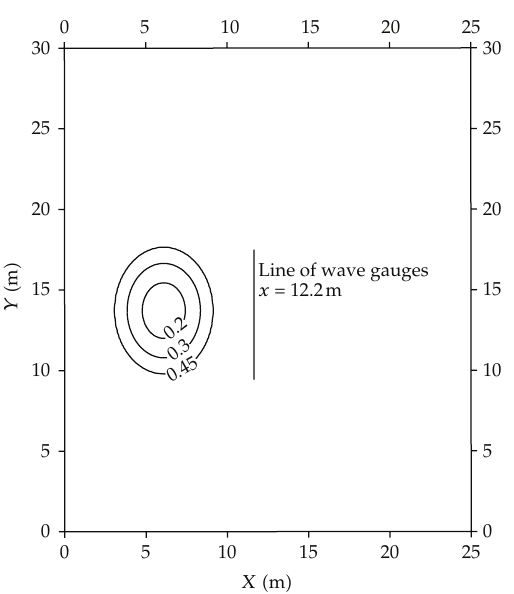
Figure 4: Experimental setup of Vincent and Briggs (cid:3) 24 (cid:4)